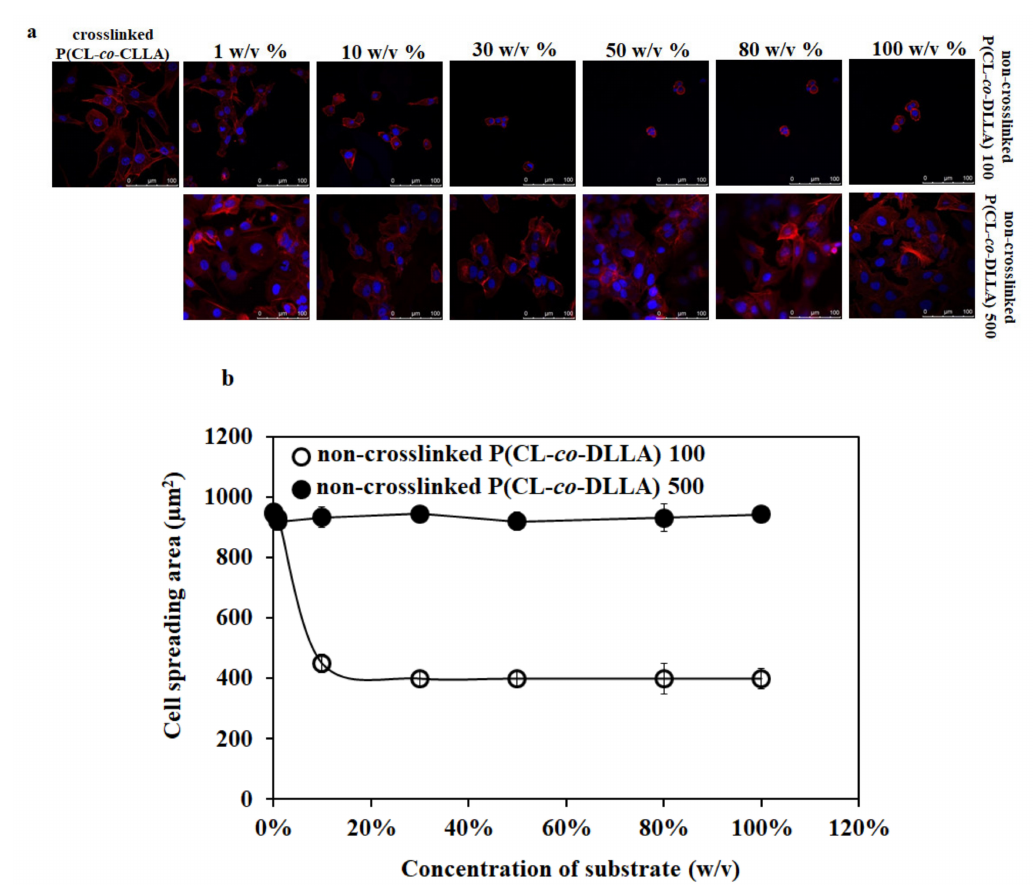
Figure 1. ( a ) Confocal microscopic images of cell spreading behavior of MCF-7 cells on